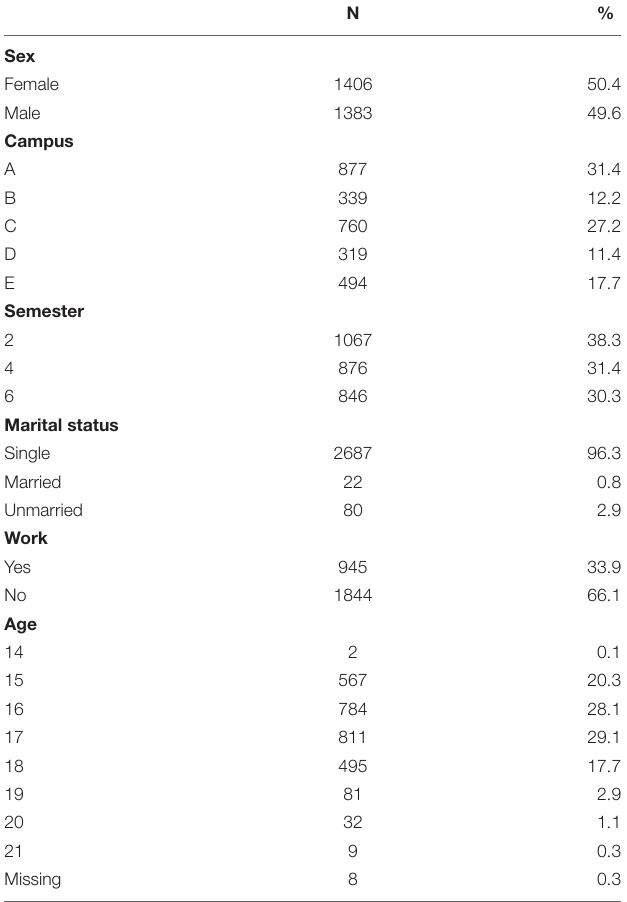
TABLE 1 | Distribution of demographic characteristics ( n = 2,789) a